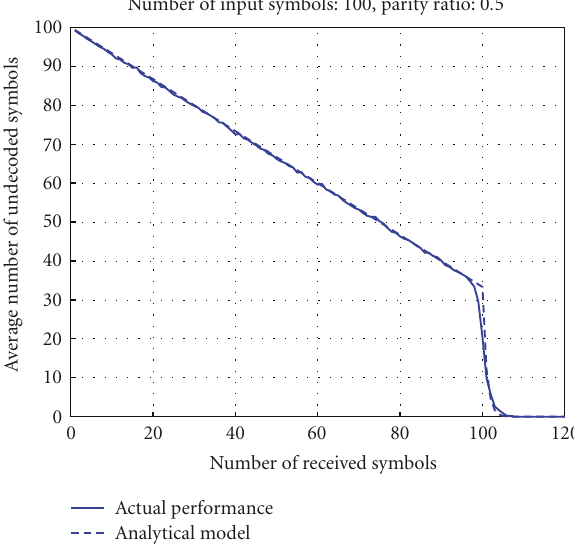
Figure 11: Performance curve of Raptor coding, N i = 100, ρ = 0 . 5 .